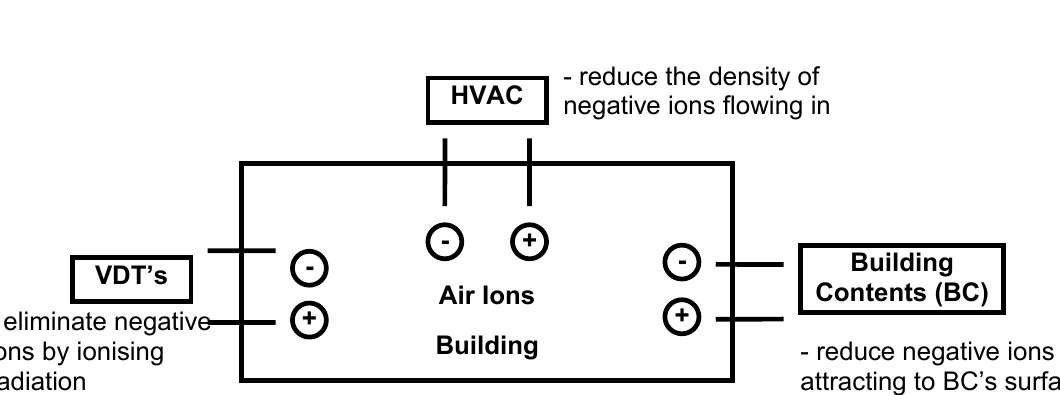
Figure 1: Three main factors affecting negative ion decrease in buildings